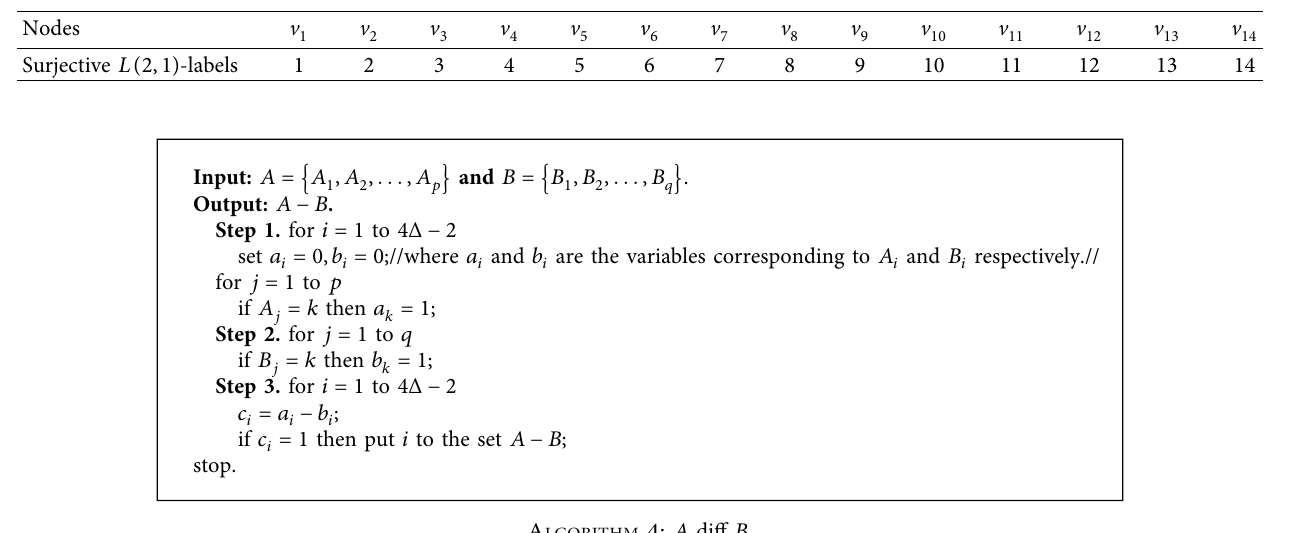
Figure 10: An IG labelled by SL21-labelling. Table 2: Nodes and their corresponding surjective